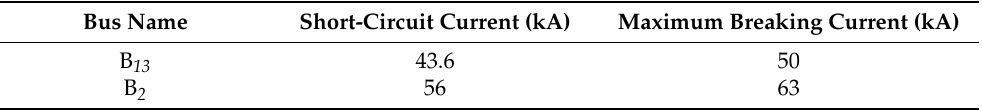
Table 2. Short-circuit current of the critical bus.